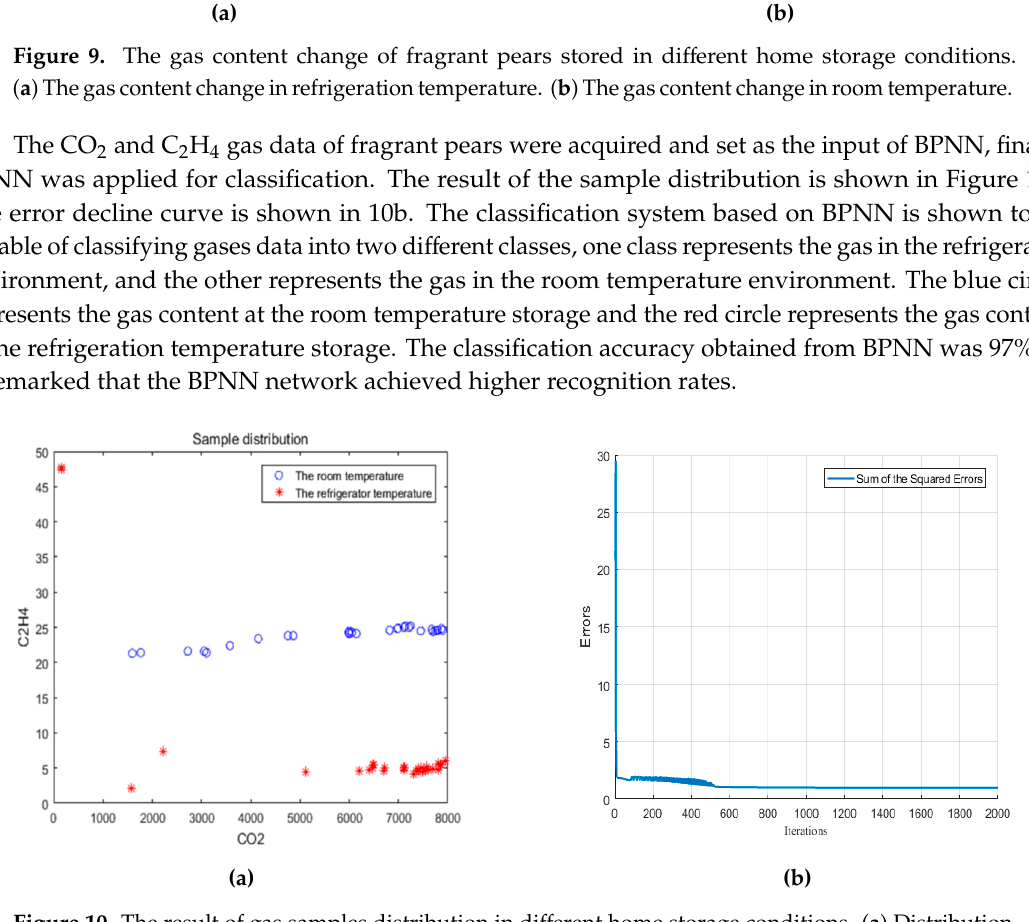
Figure 10. The result of gas samples distribution in different home storage conditions. (a) Distribution of training samples. (b) Error decline curve.